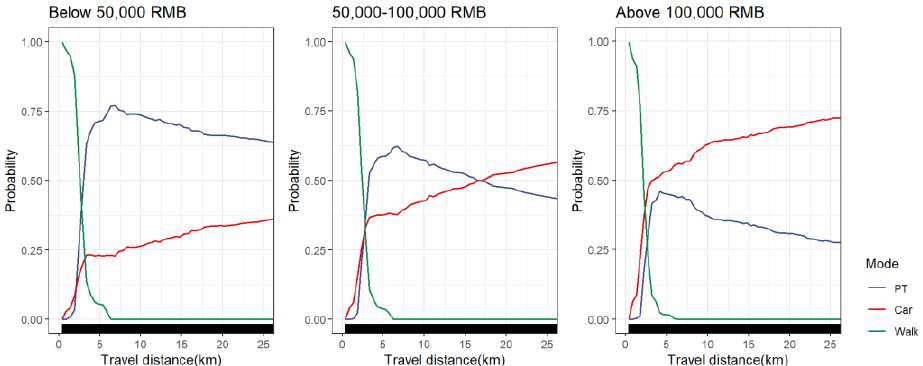
Figure 13. PDP plot of household income groups